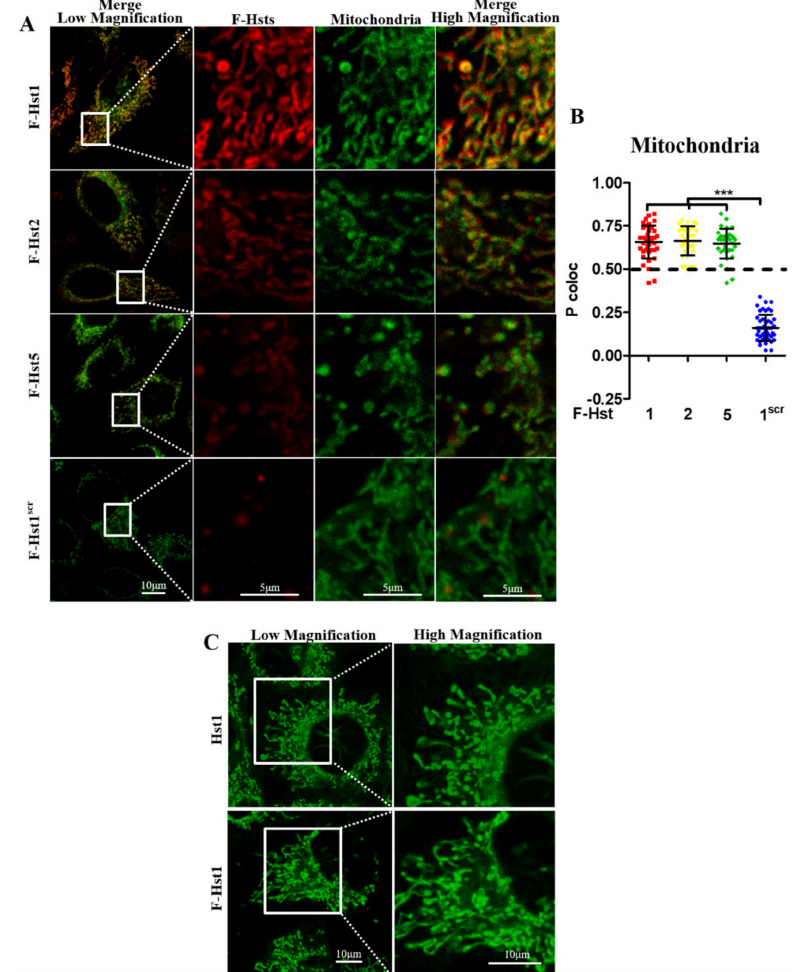
Figure 2. F-Hst1, F-Hst2 and F-Hst5 were targeted to mitochondria. ( A ) CLSM images showed F-Hst1, F-Hst2 and F-Hst5 but not F-Hst scr (in red) showed co-localization with mitochondria (in green). ( B ) The Pearson’s correlation analysis showed that F-Hst1, F-Hst2 and F-Hst5 co-localized with mitochondria with a P coloc value of about 0.65, while F-Hst scr did not show significant co-localization with mitochondria. Data were presented as mean ± SD. ***: p < 0.001. ( C ) CLSM images showed that F-Hst1 was associated with a similar morphological pattern of mitochondria (in green) as that of Hst1 (non-fluorescently